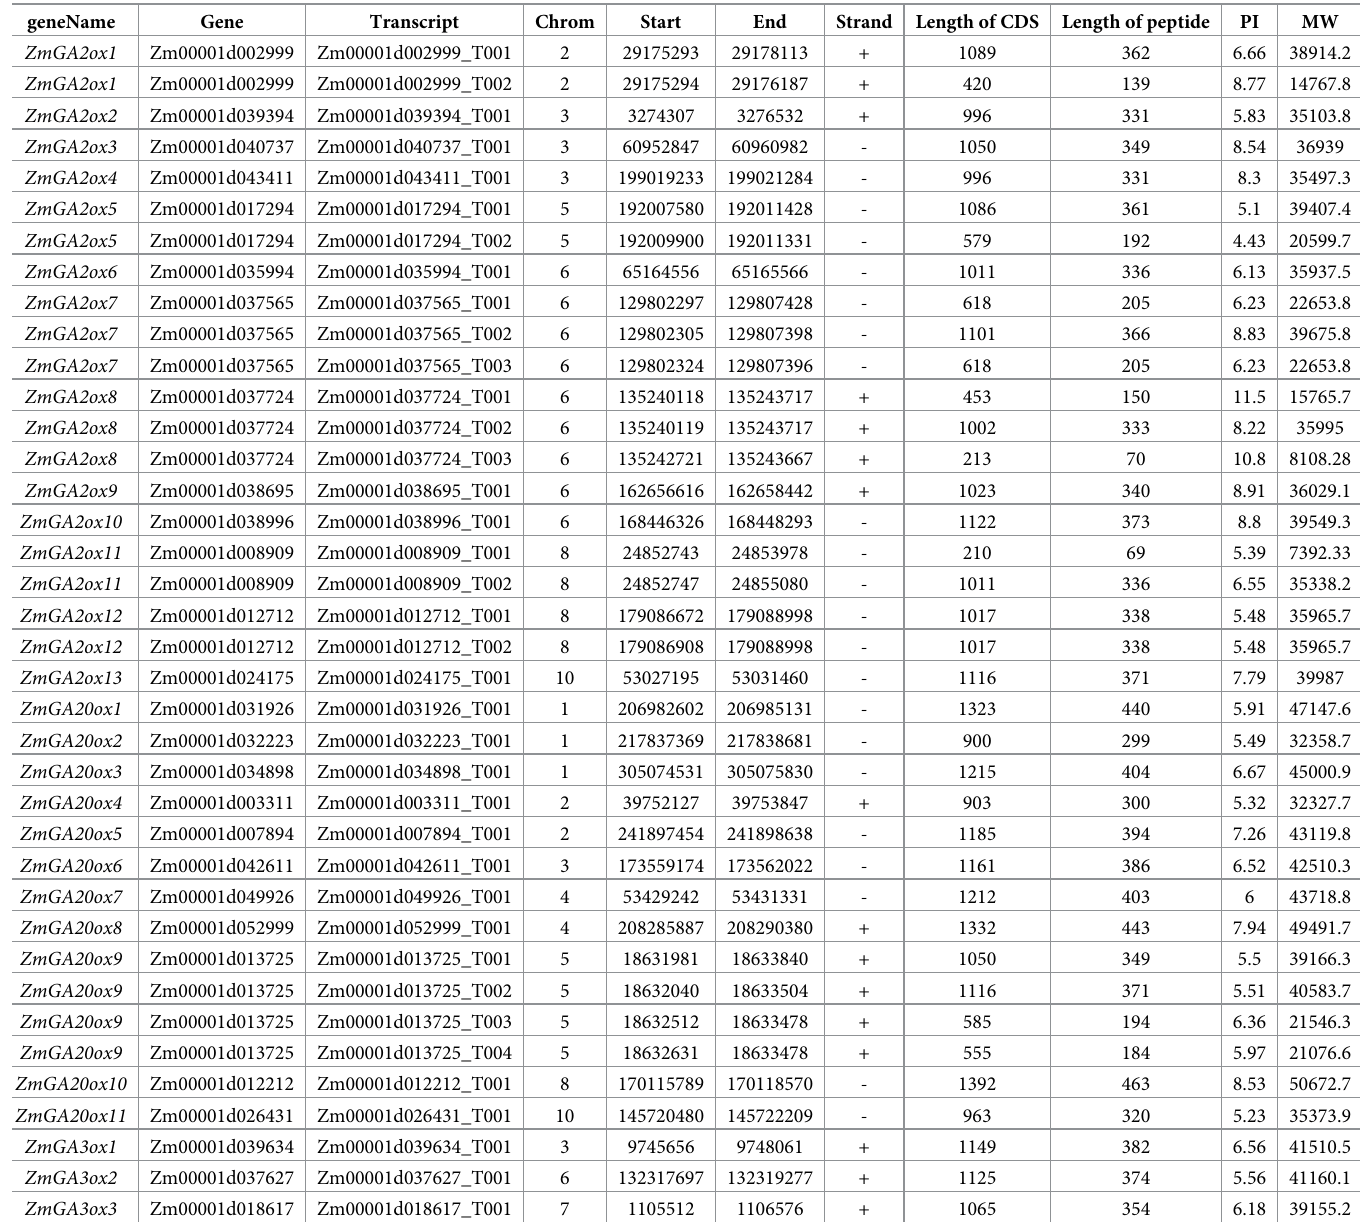
Table 1. Characteristic of gibberellin-dioxygenases genes in